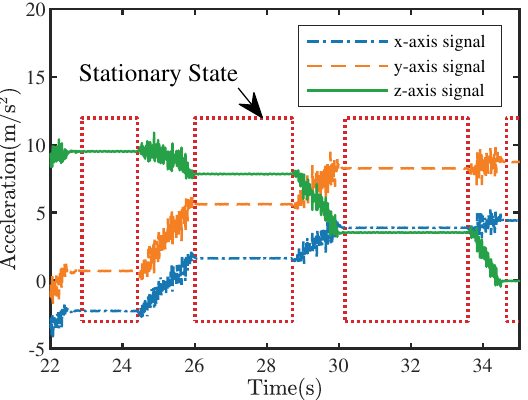
Figure 6. An example of the zero-velocity detection applied to the acceleration